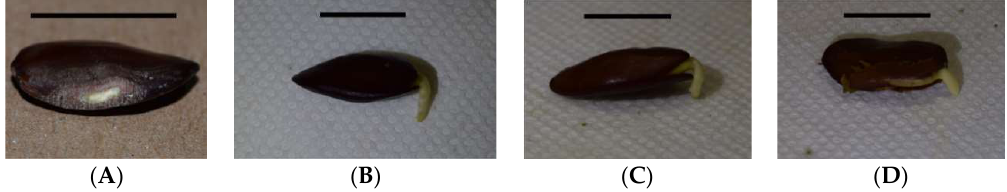
Figure 1. Appearance of Serianthes nelsonii seed after scarifying seed coat with sandpaper, exposing the light-colored cotyledon tissue ( A ). The general appearance of ( B ) Serianthes grandiflora , ( C ) Serianthes kanehirae , and ( D ) Serianthes nelsonii seeds when respiration measurements were terminated. Bars = 1 cm.